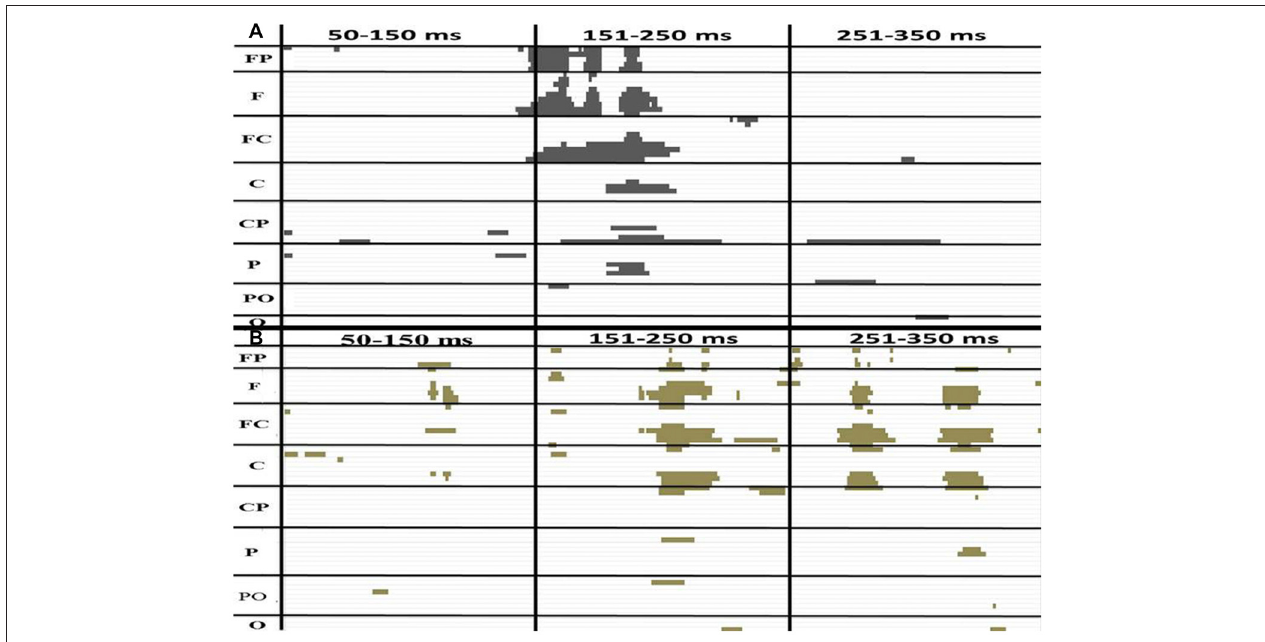
FIGURE 3 | The P -value of a paired t test between (AV + C) and (A + V) in the younger (A) and older (B) groups. The x and y axes showed the timeline and electrodes, respectively. The figure only shows point at which the P -value is less than 0.05. The FP electrode group includes FP1, FPZ, FP2. The F group includes F7, F5, F3, F1, Fz, F2, F4, F6, F8. The FC group includes FT7, FC5, FC3, FC1, FCz, FC2, FC4, FC6, FT8. The C group includes T7, C5, C3, C1, Cz, C2, C4, C6, T8. The CP group includes TP7, CP5, CP3, CP1, CPz, CP2, CP4, CP6, TP8. The P group includes P7, P5, P3, P1, Pz, P2, P4, P6, P8. The PO group includes